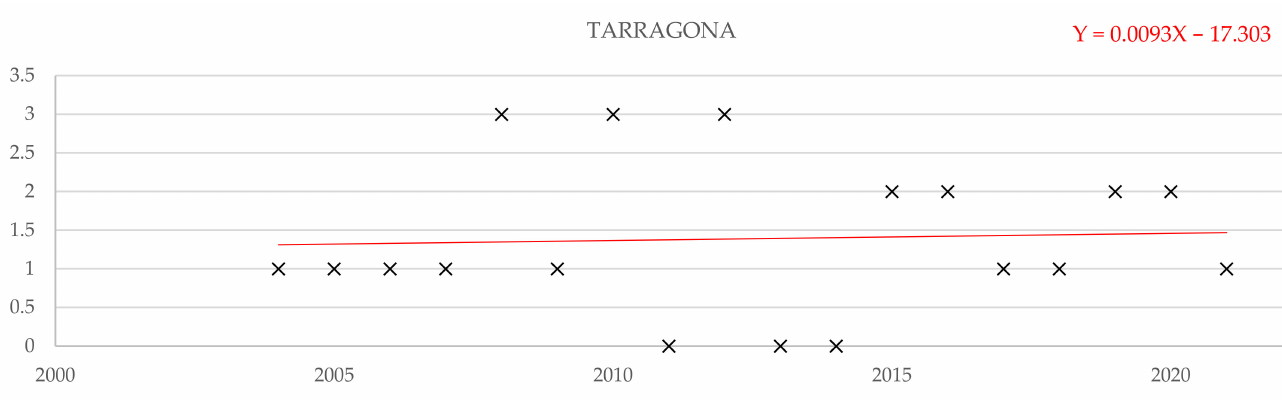
Figure 30. Number of times Tp has exceeded the expected Tp in 100 years in Mahon.